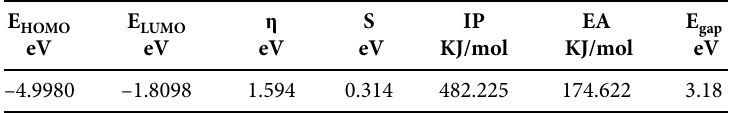
Table 2. Theoretically computed HOMO and LUMO energies, Bond gap energy (E gap ), Hardness (η), softness (S), Ionization potential (IP), Electron affinity (EA) E